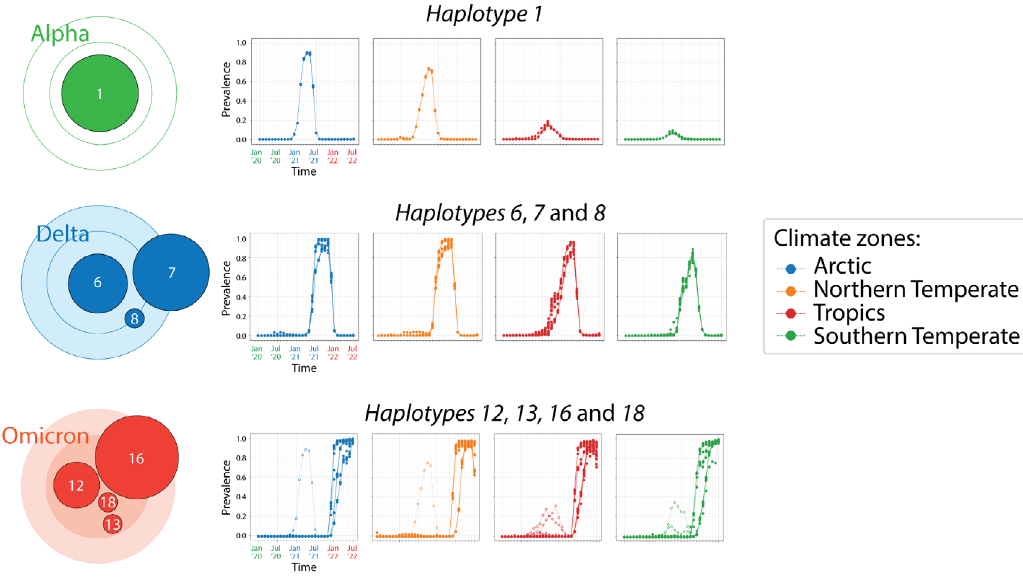
Figure 6. Patterns of mutation accumulation in core haplotypes of VOCs revealing seasonal behavior. Separateplotsdescribeoverlapsofmutationaccumulationcurvesforthefourclimatezones.Opensymbolsdescribe regions of the timeline unrelated to the VOC of